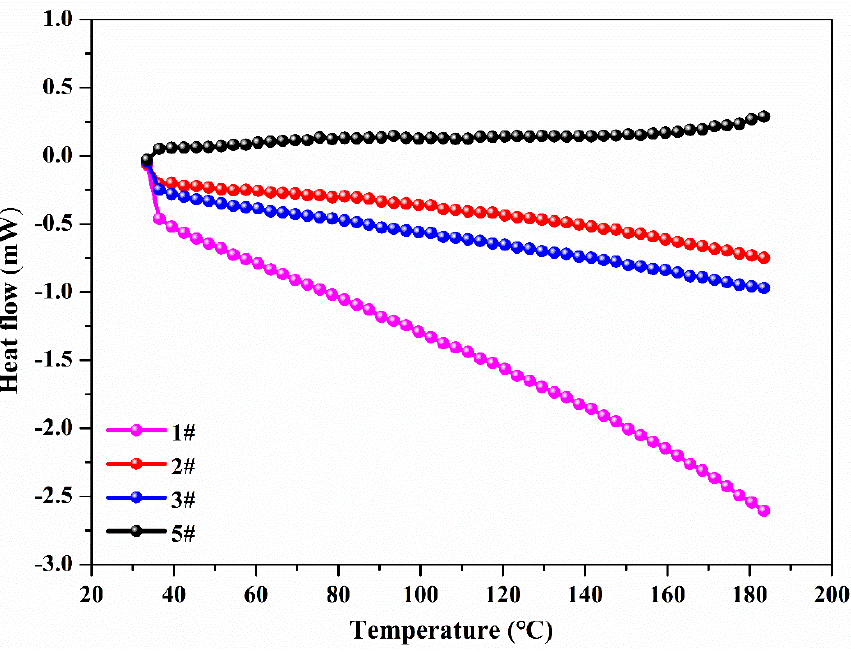
Figure 7. DSC differential spectrum curve.